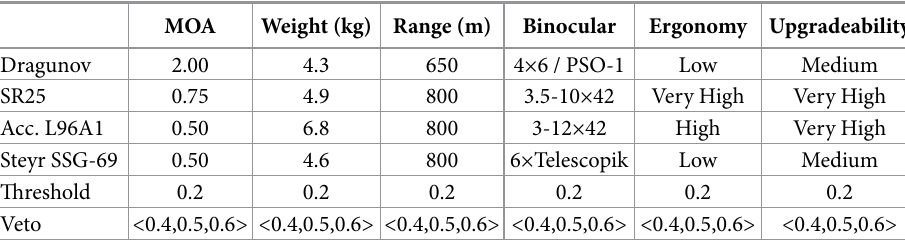
Table 1. Sniper guns and criteria with threshold and fuzzy veto values MOA Weight (kg) Range (m)